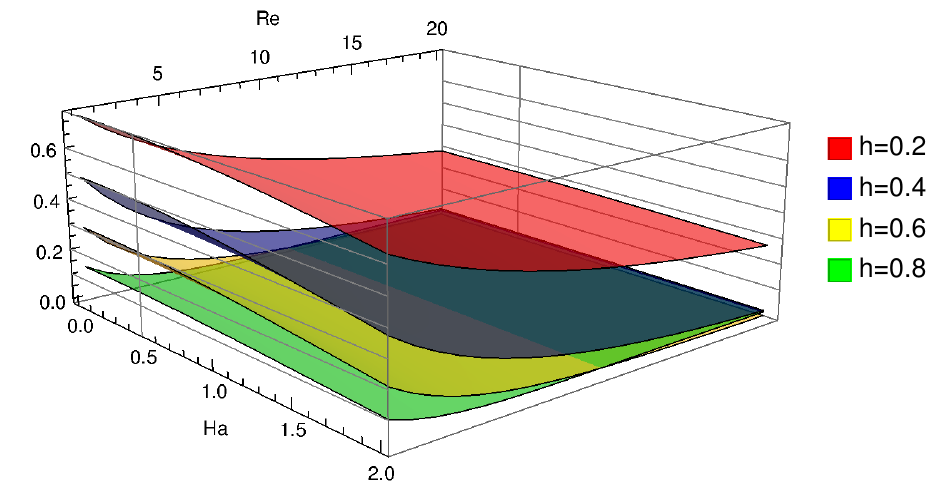
Figure 7. The combined influence of Re and Ha on U . The red surface corresponds to y = 0.2, the blue surface to y = 0.4, the yellow surface to y = 0.6 and the green one to y = 0.8.